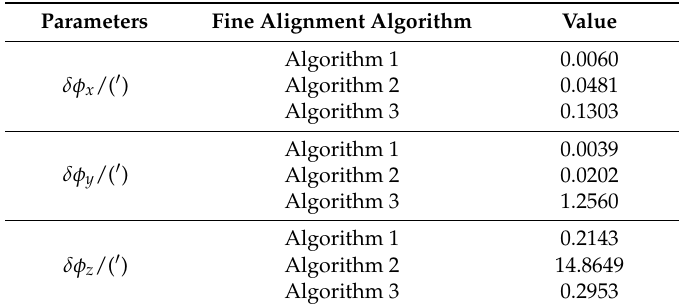
Table 3. Estimation errors (RMS) of fine alignment algorithms in simulation.